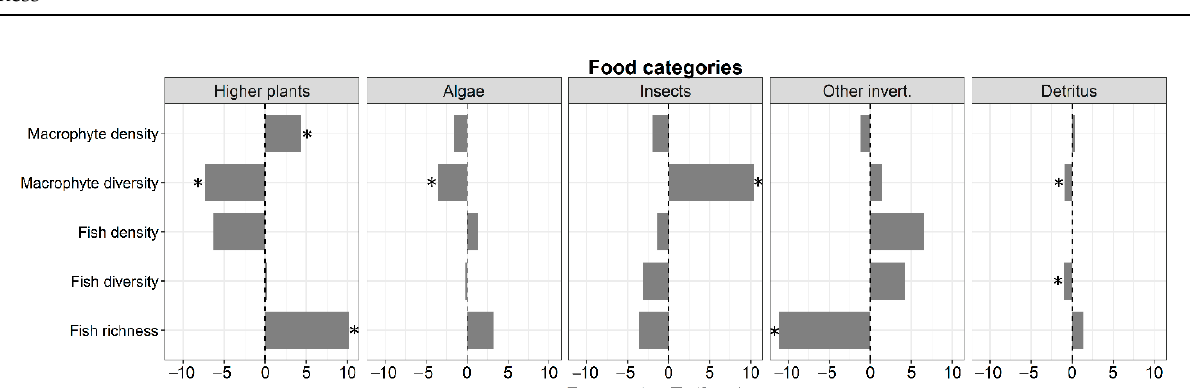
Figure 3. Parameter estimates of generalized linear models for the consumption of five food categories (higher plants, algae, insects, other invertebrates, and detritus) in relation to macrophyte and fish attributes. The dashed lines represent the confidence intervals. * = statistically significant